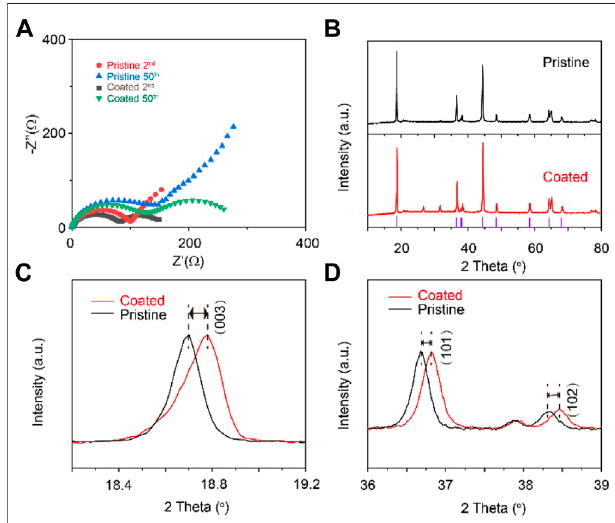
FIGURE 4 | Comparison of (A) EIS curves and (B – D) XRD patterns of Li